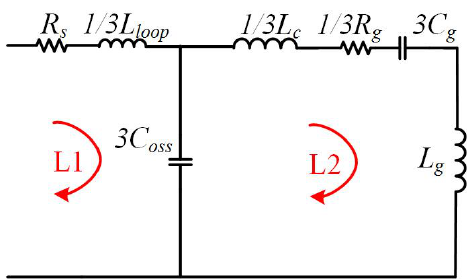
Figure 19. CM equivalent circuit of the motor drive in HF range.